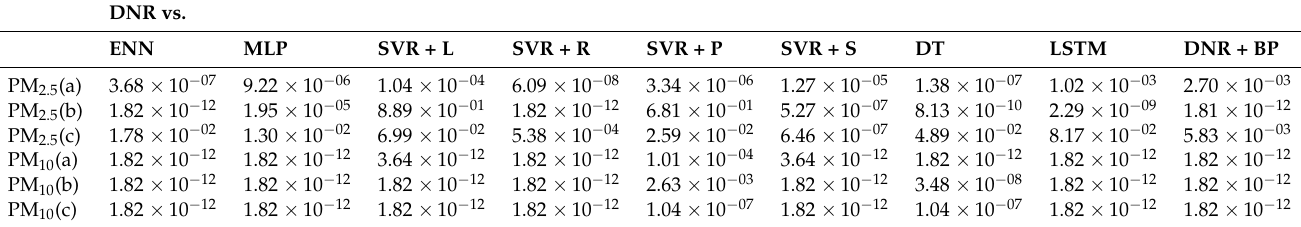
Table 7. Resulting statistical Wilcoxon tests of the prediction models compared with DNR. DNR